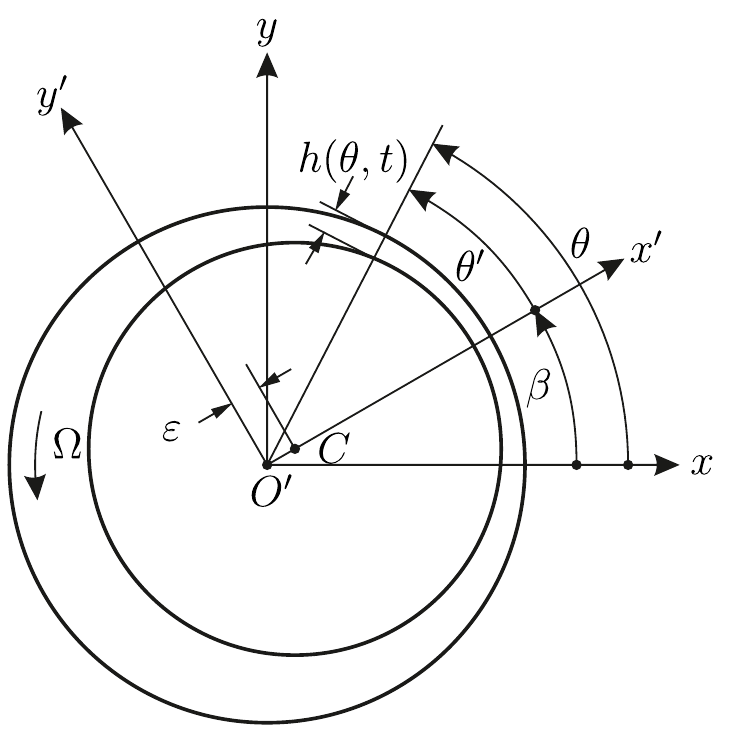
Figure 2. Geometrical definitions of a fluid-film bearing (adapted from